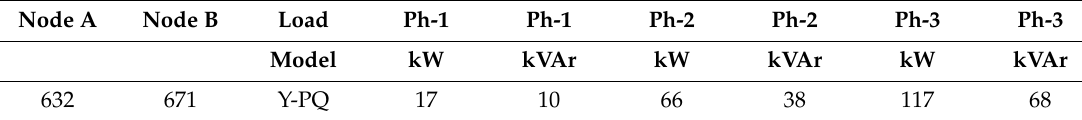
Table A2. Distributed Load Data.